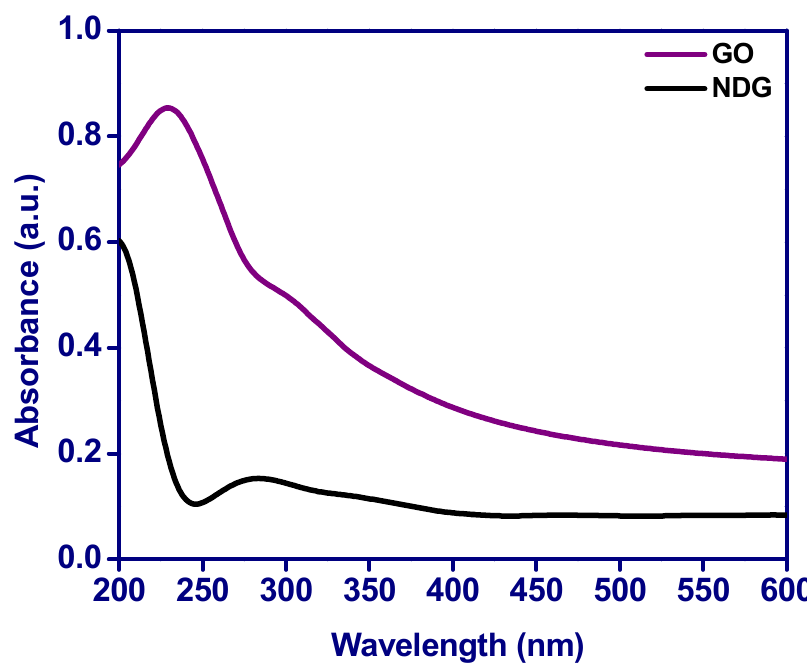
Figure 1. UV-Visible spectra of graphene oxide (GO) and nitrogen-doped graphene (NDG).